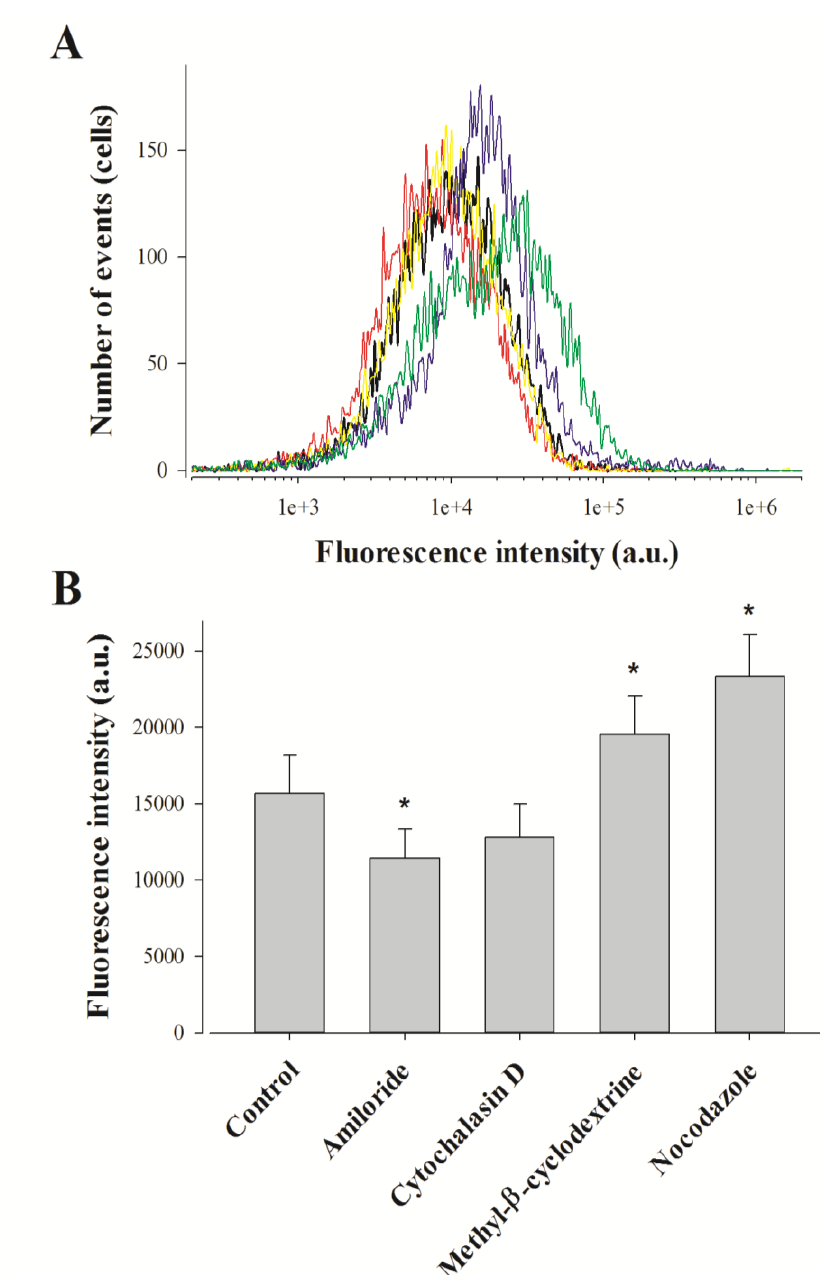
Figure 2. Effect of endocytosis inhibitors on MCa peptide penetration in F98 cells. ( A ) UF1-9 Representative FACS data showing the effect of amiloride (red curve), cytochalasine D (yellow curve), methyl-  -cyclodextrine (blue curve) and nocodazole (green curve) on 1 µM MCa -C-Cy5 cell entry (black curve). ( B ) Average fluorescence intensities for the cell UF1-9 entry of 1 µM MCa -C-Cy5 in F98 cells without and with endocytosis inhibitors. UF1-9 * p ≤